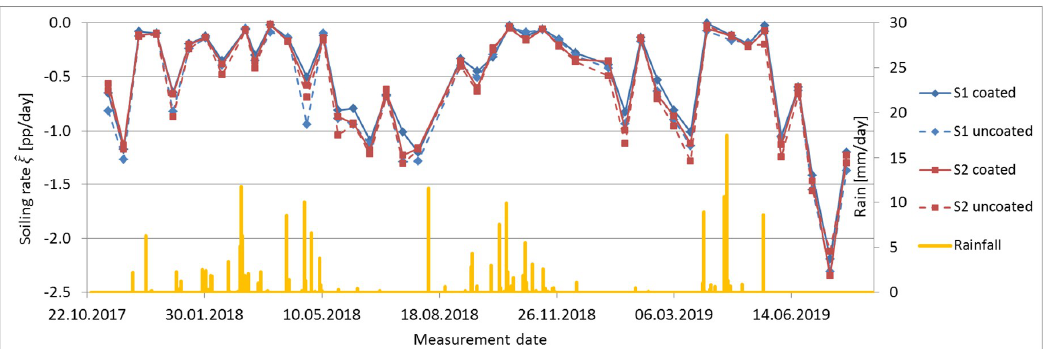
Figure 6. Soiling rate for both materials and structures.